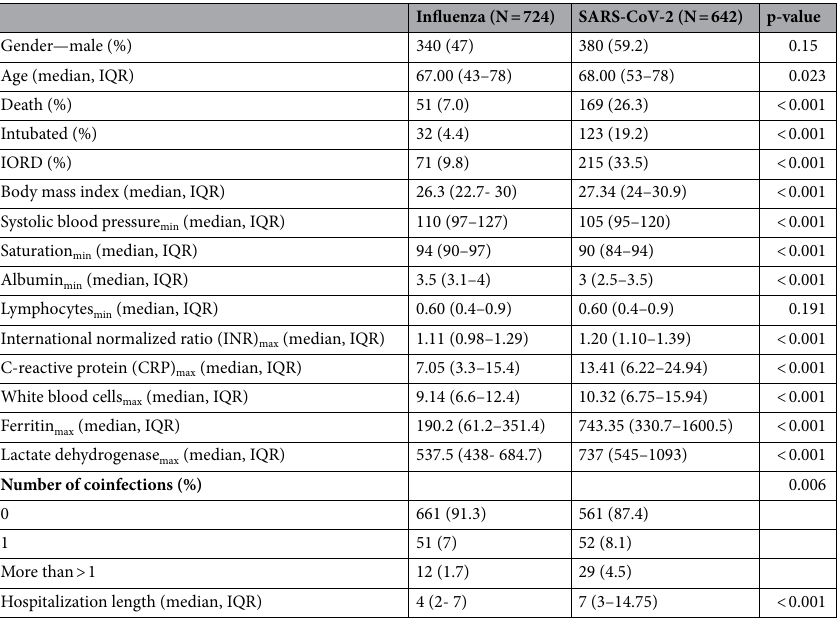
Table 1. Patient’s demographic and clinical characteristics. Data are shown as median (interquartile range (IQR)) or n (%) as indicated. min, minimal levels; max, maximal levels, IORD, intubation or